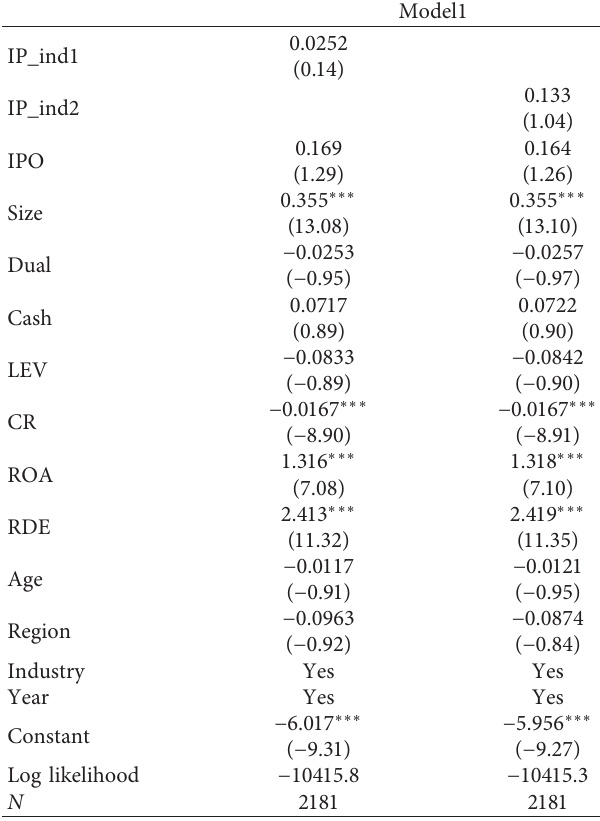
Table 3: The impact of general incentives (key encouragement) on the innovation output of entrepreneurial